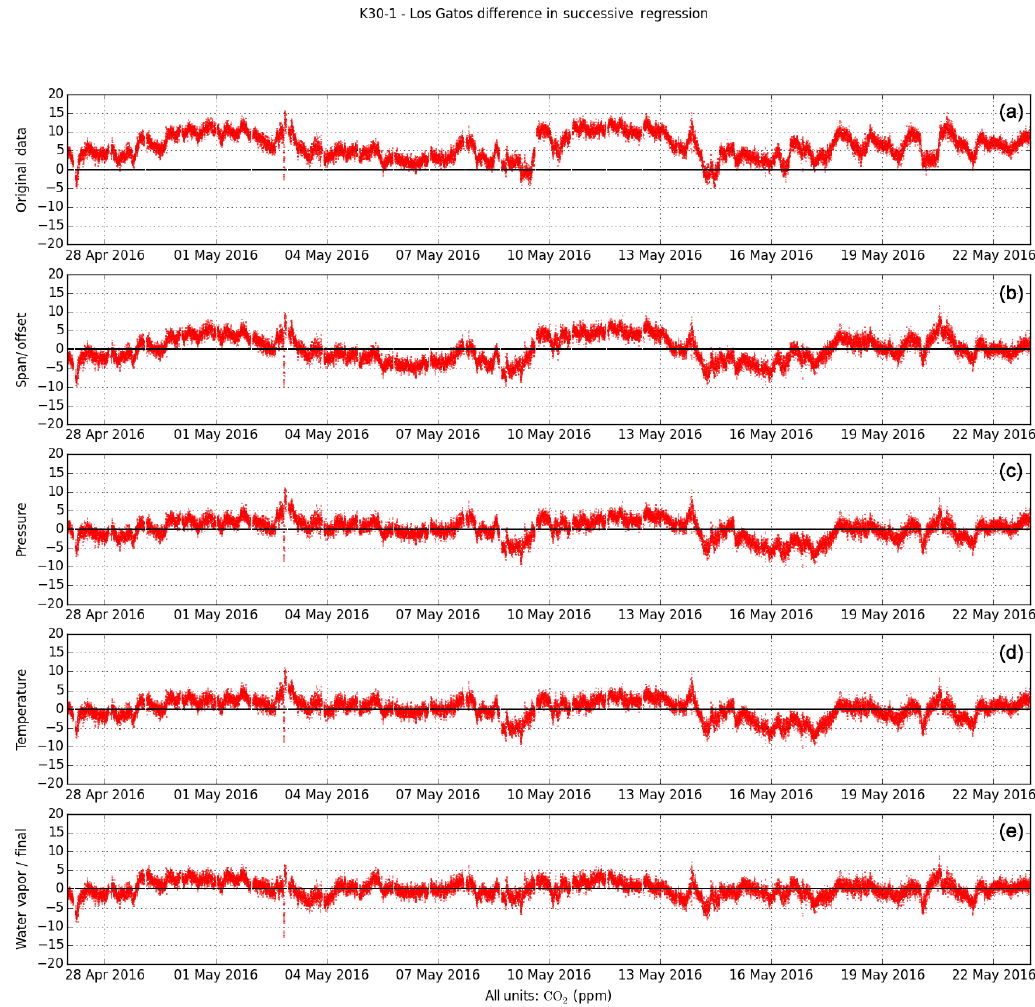
Figure 7. Difference plots for K30-1 compared to the LGR during each step of the successive regression described in Sect. 5.1 and shown in Fig. 6 for 1min averages. Cumulative, in order from top to bottom: the original dataset, after correcting for span and offset, after correcting for pressure, after correcting for temperature and, finally, after correcting for water